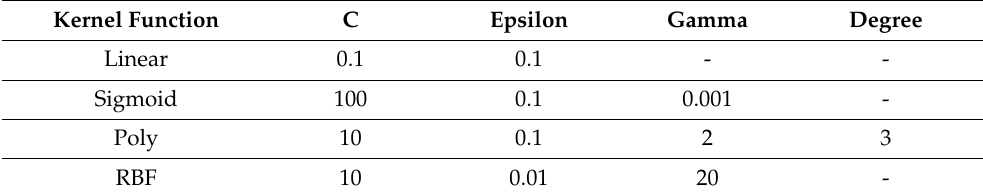
Table A2. Optimal training constants and kernel functions for developing SVM models.